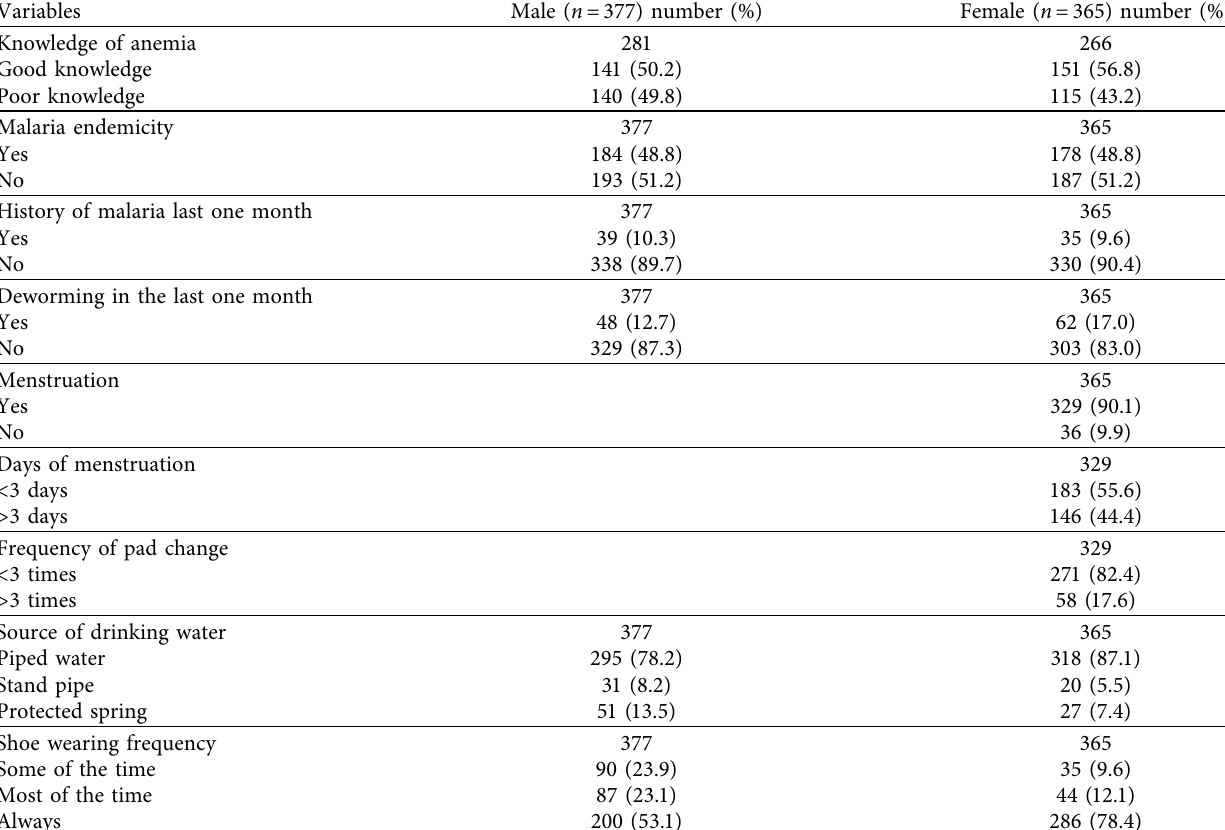
Table 3: Health service, personal practices, and related factors among male and female adolescent students in Dilla Town, Gedeo Zone, Southern Ethiopia, May 2018.